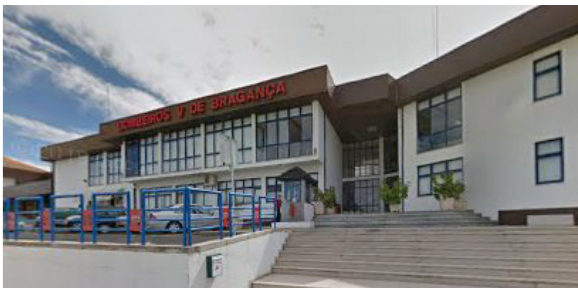
Figure 1. Main façade of the